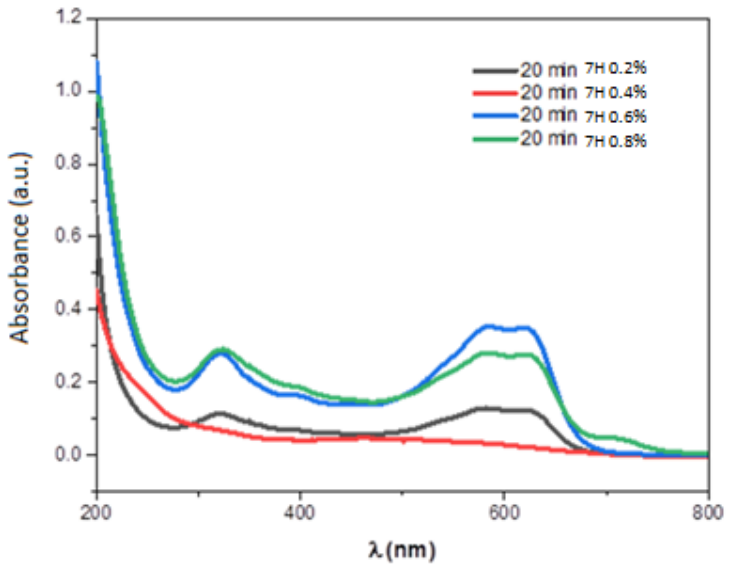
Figure 13. UV − Visible spectra of BA-dye in the presence of PbS/SiNWs nanohybrids (20 min) as a catalyst for different volume concentration (0.2% 0.4% 0.6%, and 0.8%).